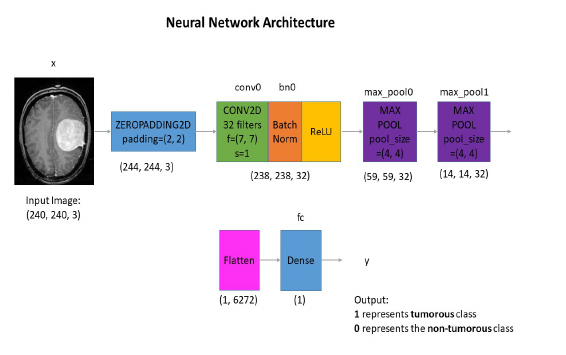
Figure 4. CNN architecture